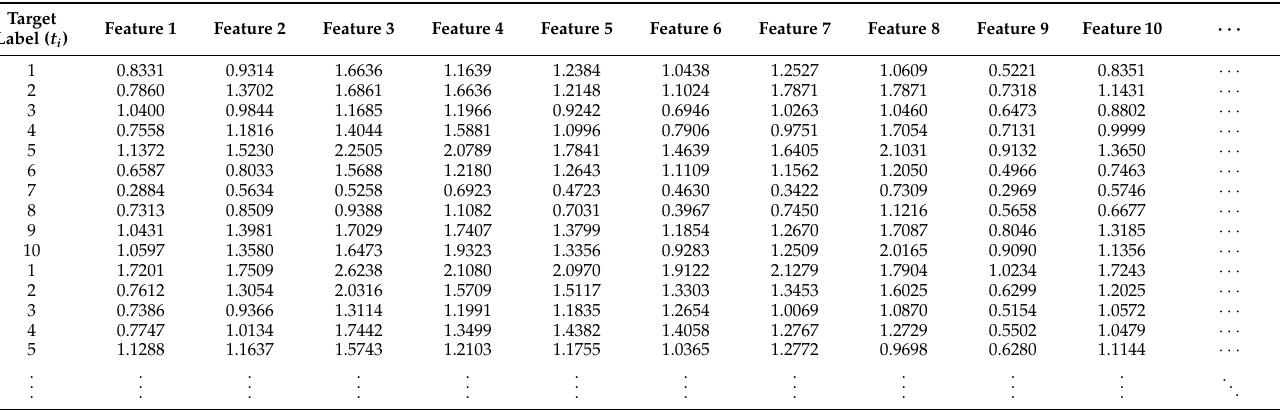
Table 5. Results recovered by Algorithm